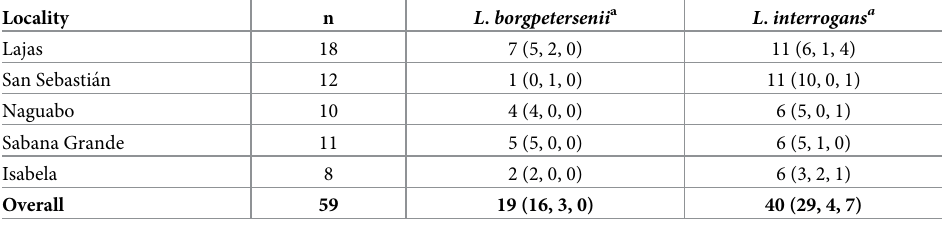
Table 2. Leptospira species infecting invasive small mammals captured on Puerto Rican cattle farms during sum- mer 2014 and 2015. Assignments were inferred using LipL32 sequence data from renal tissue. Locality